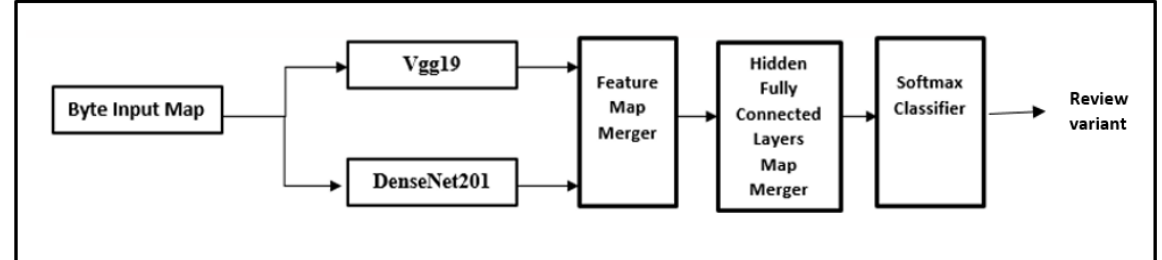
Figure 1. The ensemble consumer behavior classification model.